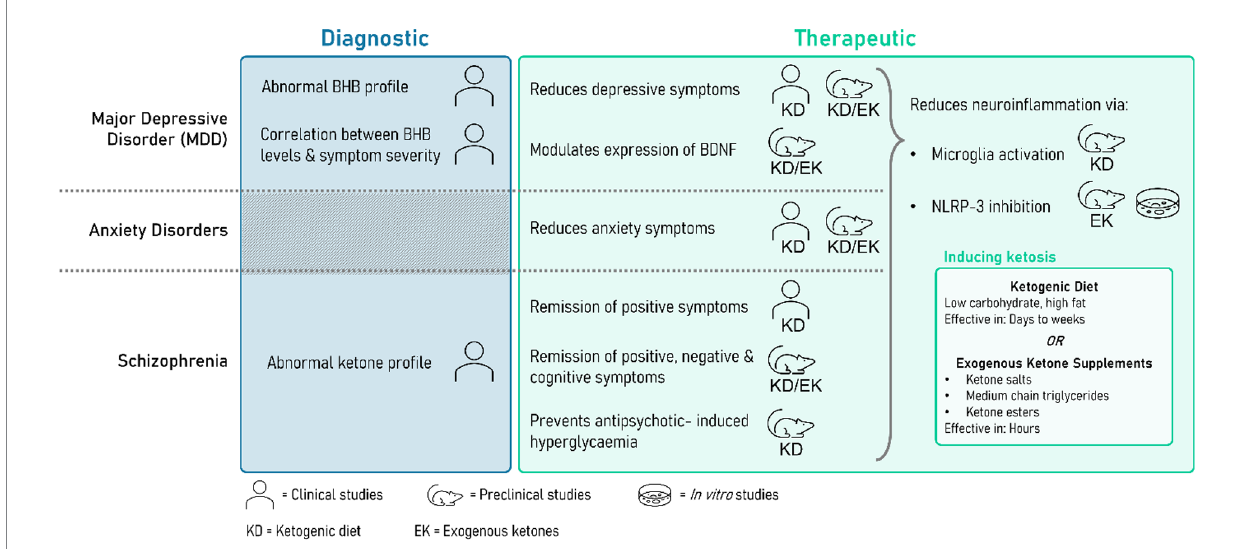
FIGURE 1 Summarizing the potential diagnostic and therapeutic uses of ketone bodies (KBs). Some clinical studies have shown monitoring levels of KBs may be clinically relevant in establishing psychiatric disease status, severity, and treatment prognosis. A range of preclinical and clinical studies have successfully demonstrated the therapeutic relevance of ketosis as induced by either a ketogenic diet or exogenous supplementation. This summary highlights the limited number of clinical studies focusing on exogenous